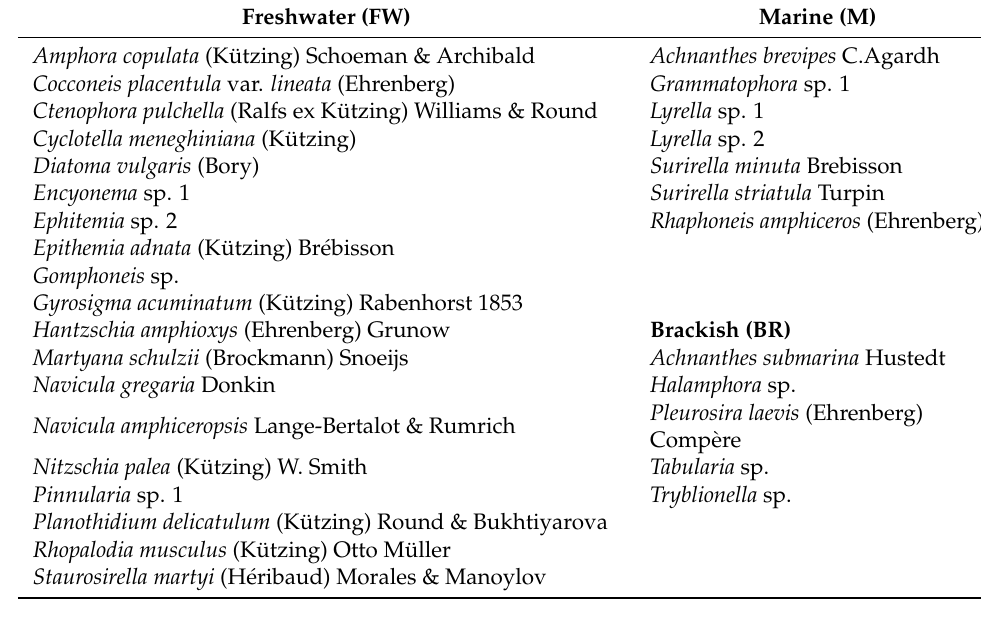
Table A1. List of diatom taxas present on the sediments of the Pachingo core PT1. The diatoms were classified into ecological groups: Freshwater (FW), Marine benthic (MB) and Brackish.